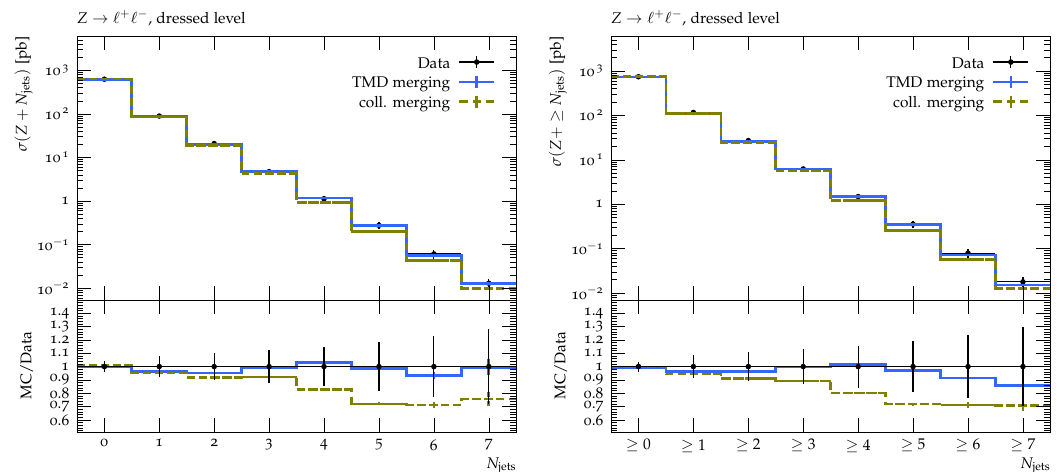
Figure 23 . Predictions obtained using Madgraph + Pythia 6 with MLM merging and the TMD merging framework are compared for exclusive (left) and inclusive (right) jet multiplicity distribu- √ tions in the production of a Z -boson in association with jets, at s = 13 TeV. The phase space for the calculation follows the one in [91], whose data are included in these and subsequent